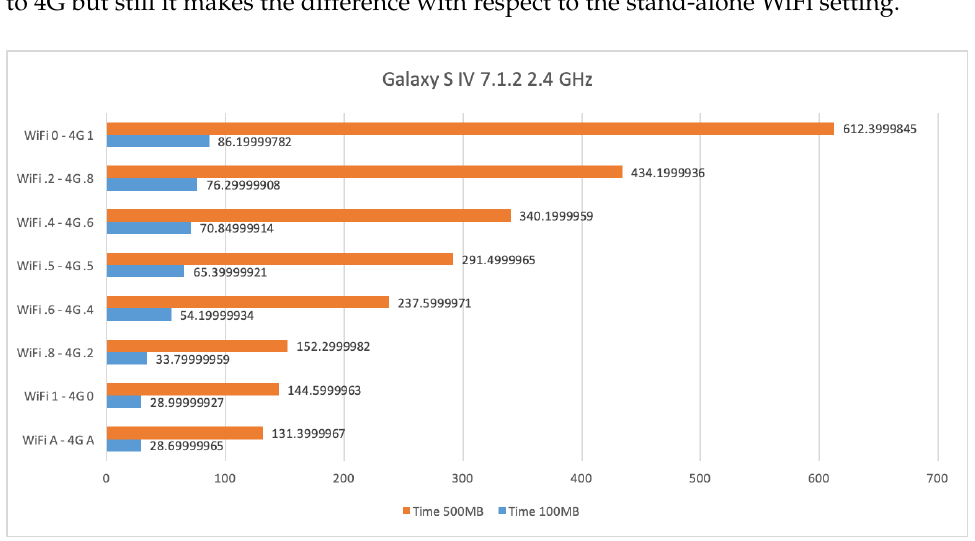
Figure 12. Time required for transferring files of size 100 Mb and 500 Mb by means of WiFi at 2.4 GHz and 4G on a Samsung Galaxy S4 with Android 7.1.2. Apart for the last line which refers to the AUTO mode, from top to bottom, the percentage of using WiFi goes from 0% to 100%, whereas the one for 4G is decreased from 100% to 0%. The best performance is obtained by means of the AUTO mode.